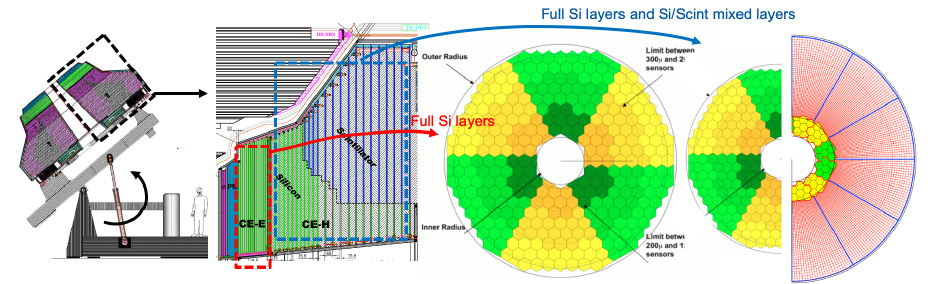
Figure 1. The design of HGCAL [4]. Left: Sketch of HGCAL endcap. Mid-left: The internal structure on the longitudinal-radial (z-r) plane. Red and blue rectangles indicate regions of CE-E and CE-H respectively, where CE-E has 28 full Si layers and CE-H has 8 full Si layers plus 14 Si-scintillators hybrid layers. Mid-right, Right: Layouts of CE-E and CE-H layer. Silicon wafers are shown as yellow and green hexagons and scintillators are shown as red mesh. Darker, medium and lighter shades of hexagons represent silicon wafers with thickness of 120, 200 and 300 µ m